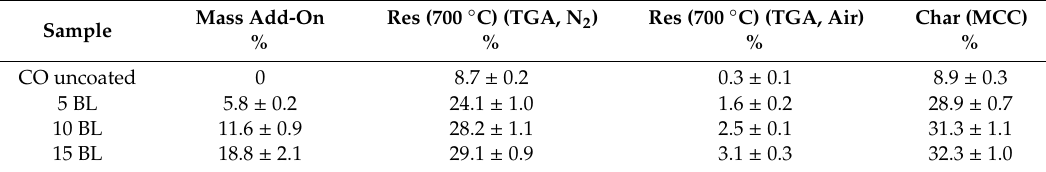
Table 4. Comparison between mass add-on and obtained char after TGA and MCC analyses.